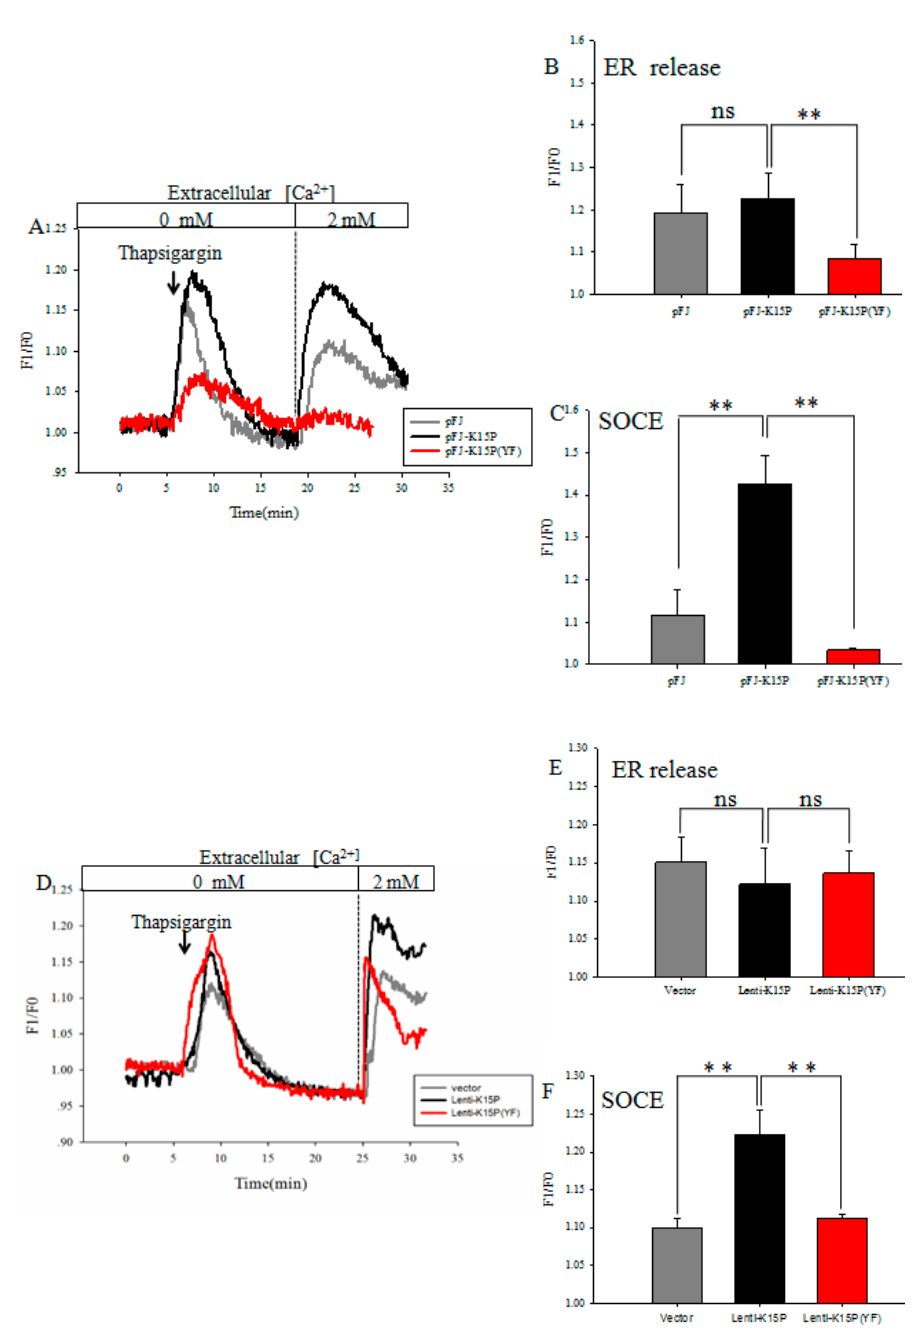
Figure 1. Store-operated calcium entry (SOCE) in HEK-293T and EA.hy926 cells. ( A ) Changes in cytosolic Ca 2+ concentration ([Ca 2+ ] cyto ) were measured in HEK-293T cells. Representative traces showing Ca 2+ release in Ca 2+ -free saline solution by Ca 2+ -indicator fura-8 and 2 mM Ca 2+ application-induced [Ca 2+ ] I rise. ( B ) Histogram in the right panel shows the average peak from the baseline after thapsigargin-induced depletion of ER Ca 2+ in HEK-293T cells. ( C ) Summary of data showing increase in [Ca 2+ ] I in response to extracellular Ca 2+ application after thapsigargin in HEK-293T cells. ( D ) Changes in [Ca 2+ ] cyto were measured in EA.hy926 cells. ( E ) Histogram in the right panel shows the average peak from the baseline after thapsigargin-induced depletion of ER Ca 2+ in EA.hy926 cells ( F ) Summary of data showing changes in [Ca 2+ ] I in response to extracellular Ca 2+ application after thapsigargin in EA.hy 926 cells. n = 5 per group (the n refers to technical replicates). Data are presented as the mean ± standard error. ** p < 0.01 .